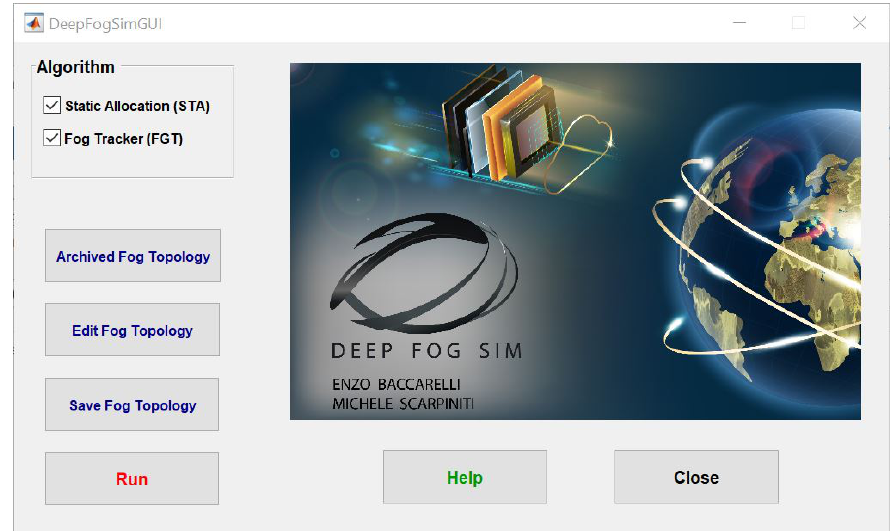
Figure A1. A screenshot of the Graphical User Interface (GUI) interface. Table A1. A synoptic overview of the functionalities offered to the user by the DeepFogSimGUI interface. Available GUI